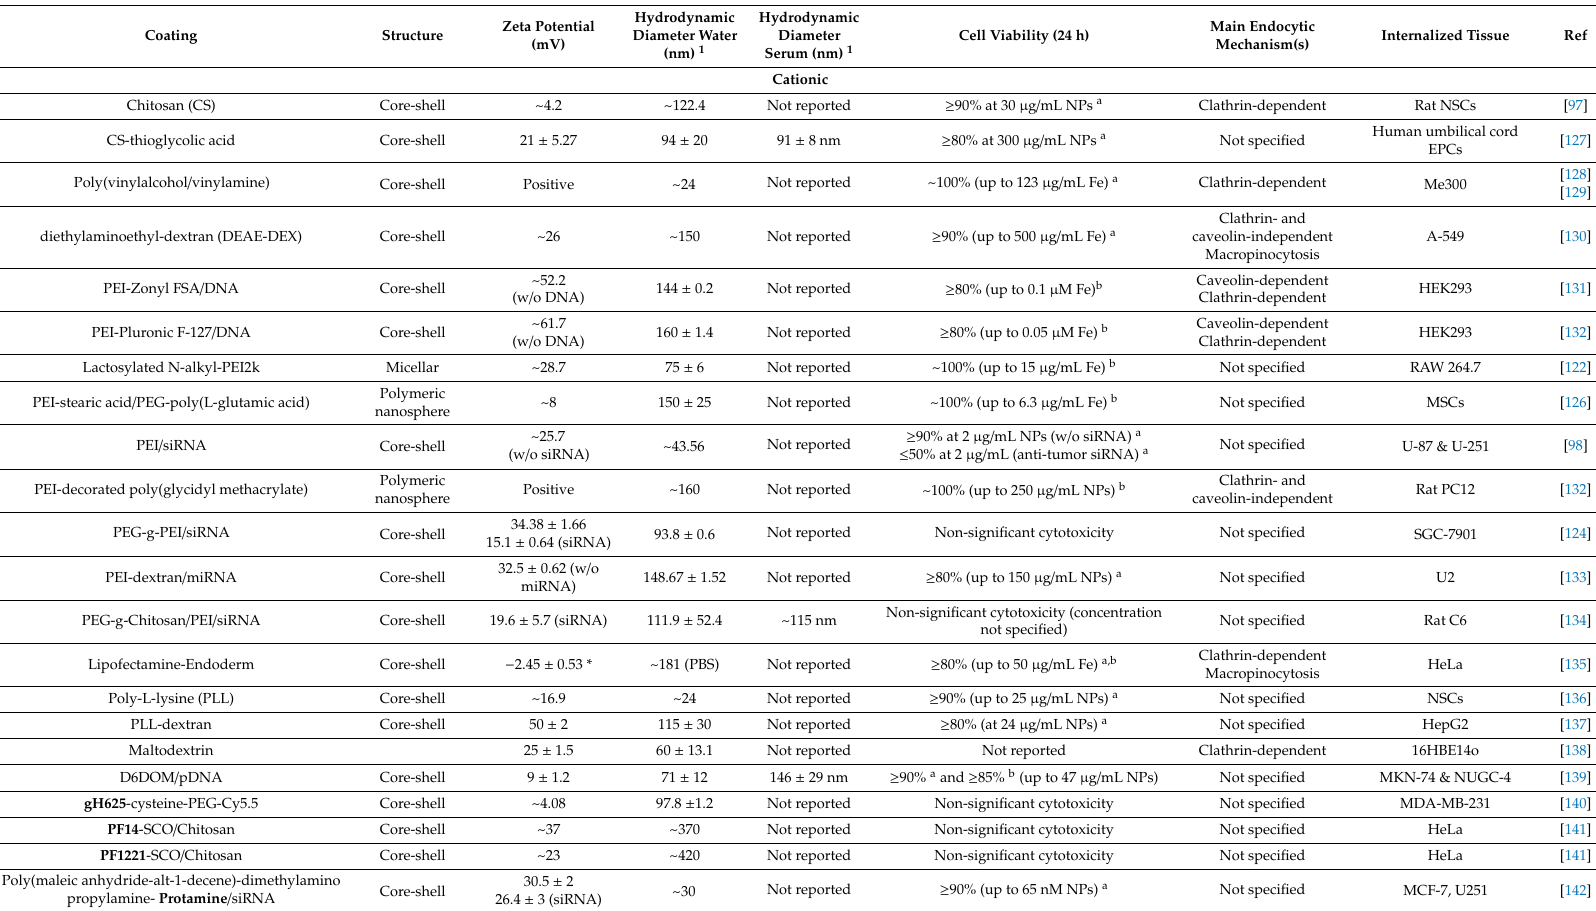
Table 1. IONs with cationic and anionic coatings that are internalized through adsorptive interactions with the